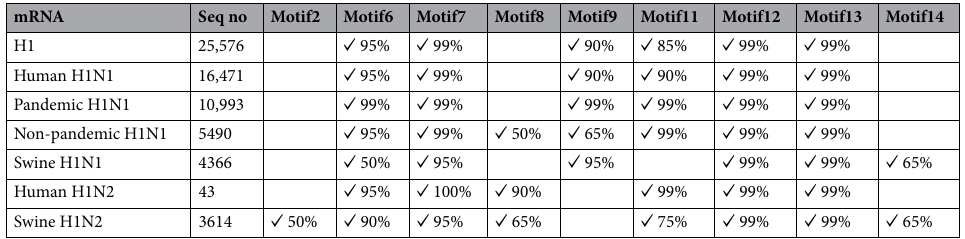
Table 2. Summary of conserved DRACHs among various species and viruses of H1 mRNAs.